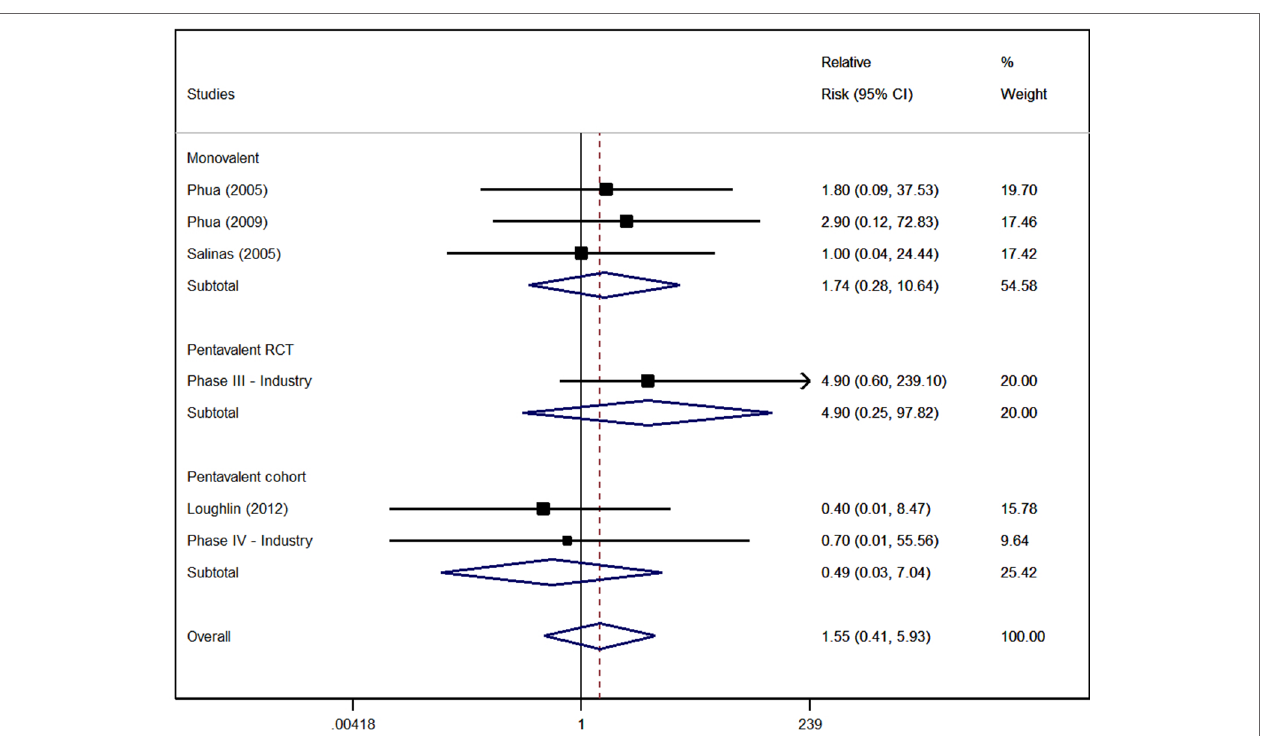
FIGURE 3 | Risk of developing Kawasaki disease due to use of rotavirus